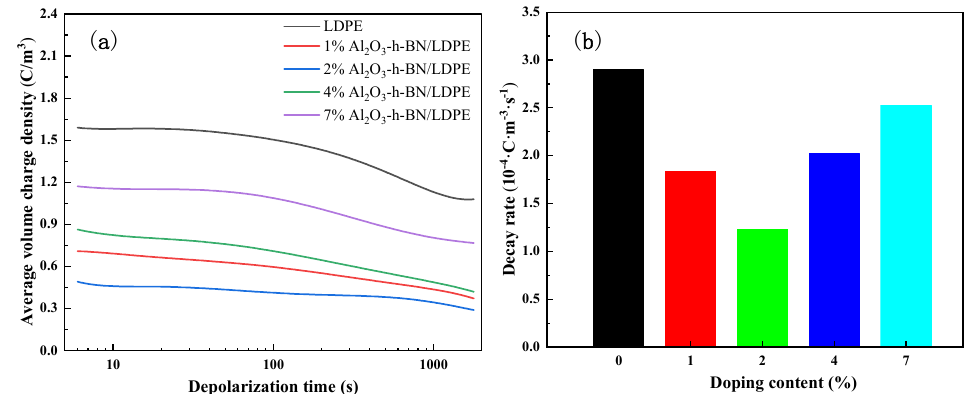
Figure 9. ( a ) Average volume-charge density and decay rate of LDPE and ( b ) its nanocomposite specimens during short circuit.